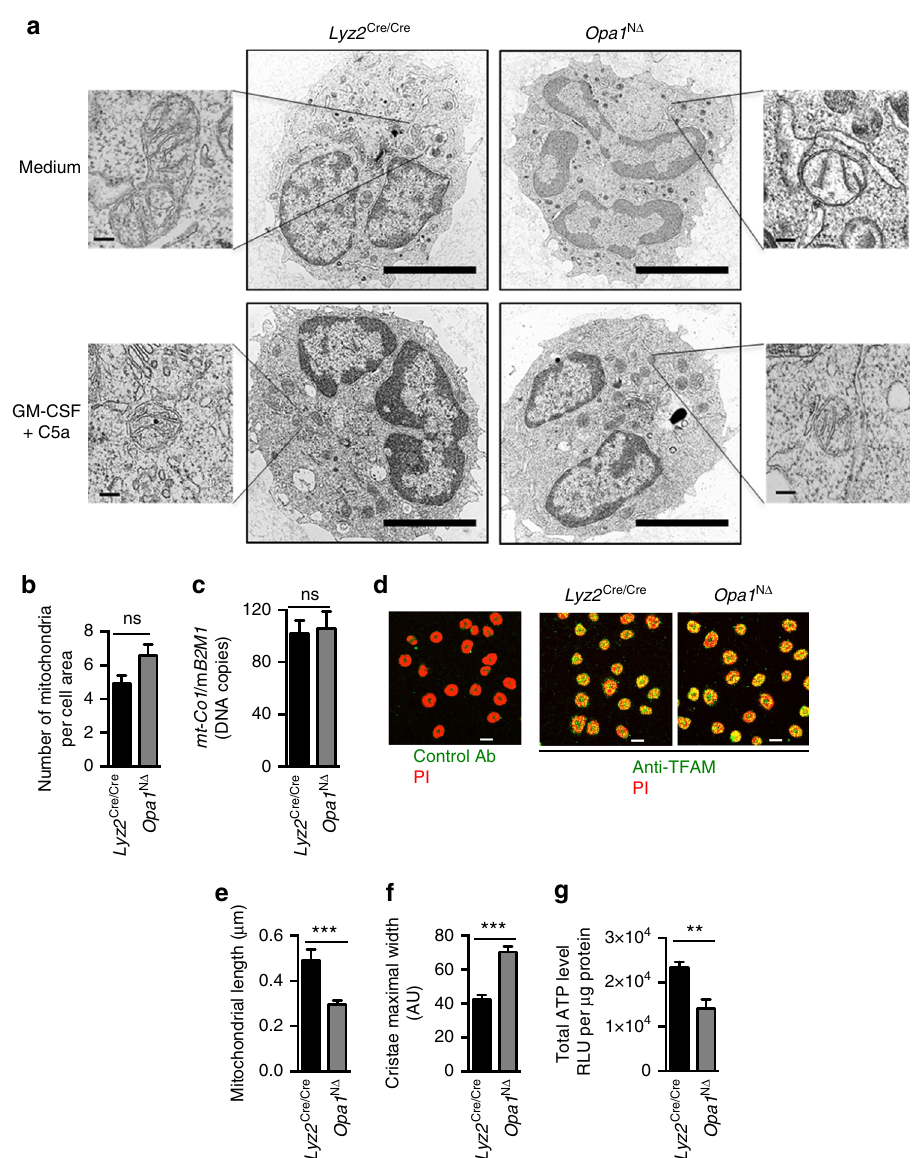
Fig. 3 Lack of Opa1 alters mitochondrial morphology and cristae structure. a Transmission electron microscopy (TEM). Primary mature neutrophils from Opa1 N Δ and control mice were fi xed and analyzed. Representative images are shown. Bars, 5 µ m. Insets to the sides, bars, 1 µ m. Mitochondria were further analyzed at higher magni fi cation and statistical analyses are provided below in ( b ), ( e ), and ( f ). b The average numbers of mitochondria per neutrophil was quanti fi ed in at least 100 cells. Values are means ± SEM ( n = 3); n.s., not signi fi cant. c Quantitative PCR. Freshly puri fi ed mature neutrophils from Opa1 N Δ and control mice were analyzed for the number of DNA copies of mitochondrial mouse cytochrome c oxidase subunit 1 ( mt-Co1 ) relative to mouse β 2 microglobulin ( B2M) which was used as a single copy nuclear-encoded reference gene. Values are means ± SEM ( n = 3); n.s., not signi fi cant. d Confocal microscopy. Primary mature mouse neutrophils from Opa1 N Δ and control mice were stained for TFAM expression (green) and DNA (red) using anti-TFAM antibody and PI. Bars, 10 µ m; n = 3. e Average mitochondrial major axis length in freshly puri fi ed mature neutrophils from Opa1 N Δ and control mice. Images were acquired by TEM and subsequently analyzed using the measurement points module of Imaris software. Data were collected from at least fi ve mitochondria per cell and more than 50 neutrophils per experiment. Values are means ± SEM. *** p < 0.001; n = 3. f Morphometric analysis of cristae width in 60 randomly selected mitochondria of freshly puri fi ed mature neutrophils from Opa1 N Δ and control mice. Values are lengths in arbitrary units (AU) and shown as means ± SEM. *** p < 0.001; n = 3. g Total cellular ATP production by freshly puri fi ed mature neutrophils from Opa1 N Δ and control mice was measured by ATP-dependent luciferase activity using an ATP determination kit. Relative luciferase units (RLU) are shown as means ± SEM. ** p < 0.01; n = 5. Quanti fi cation of the data obtained in activated neutrophils is provided in Supplementary Fig. microtubule network (Fig. 4a) and to release extracellular PMA, P . aeruginosa or immune complexes (Supplementary DNA following activation (Fig. 4b). Quanti fi cation of dsDNA Fig. 7a, b). in neutrophil supernatants con fi rmed the DNA release by It should be noted that addition of exogenous ATP alone did Opa1 N Δ neutrophils in the presence of exogenous ATP or not trigger DNA release either in human (Supplementary Fig. 8a) NMN (Fig. 4b, right panel). Similar results for DNA release or in mouse neutrophils (Supplementary Fig. 8b), largely were obtained following stimulation of neutrophils with excluding the possibility that Opa1 N Δ neutrophils release DNA